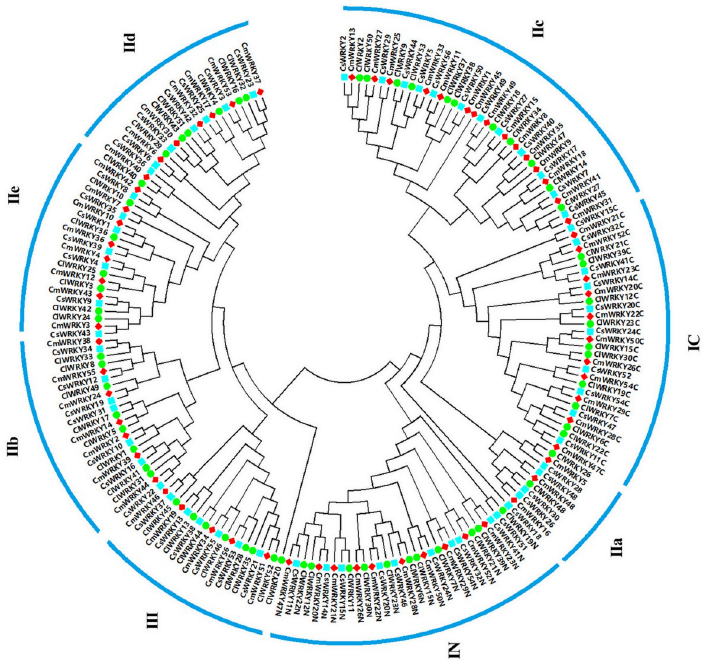
Fig 1. Phylogenetic relationships of WRKY domains from melon (red square), cucumber (blue square) and watermelon (green circle) using NJ method. The domains were clustered into three major groups I, II, III, and five subgroups (a, b, c, d, and e) in group II.